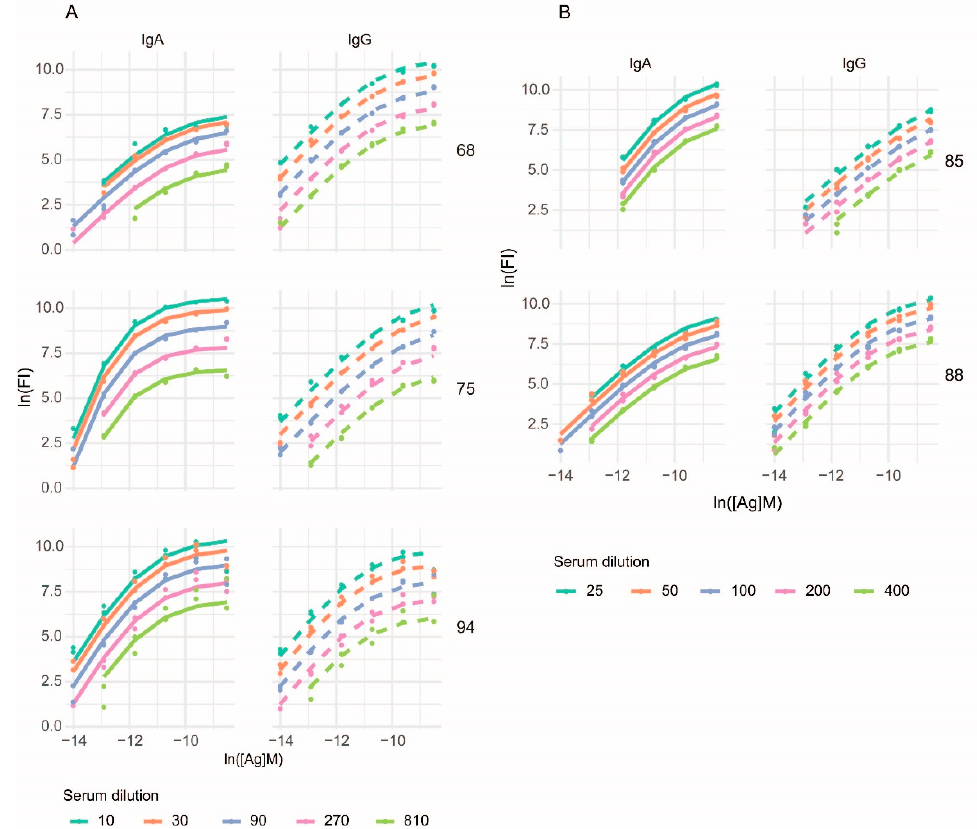
Figure 2. Fitting in two dimensions. Examples of parallel measurements of IgG and IgA binding to diagnostic celiac disease peptide epitope are shown, with serum dilutions in ( A ) three-fold and ( B ) two-fold steps, as shown beside the panels, in five representative serum samples. Dot symbols stand for measurement data, lines are fitted